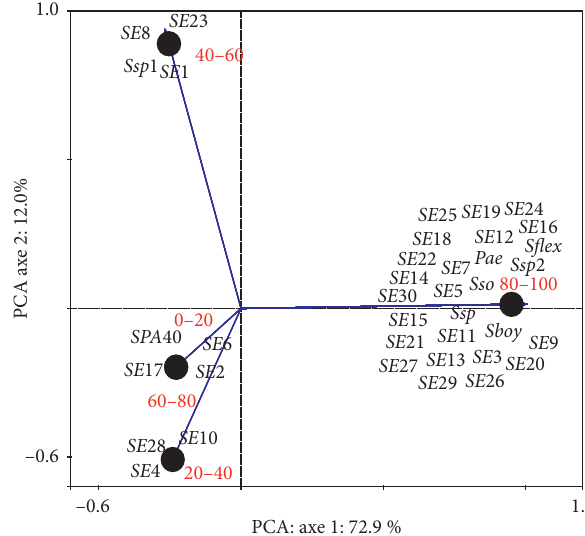
Figure 2: PCA of Shigella strains based on emulsification index (EI24). Pae: P. aeruginosa used as positive control; S. flex: S. flexneri M90T; S. flex-: S. flexneri spa40 mutant; Sboy: S. boydii ; Sso: S. sonnei ; Ssp 1, 2: Shigella sp. from clinical strains; SE1 to SE30: Shigella sp. from environmental strains.